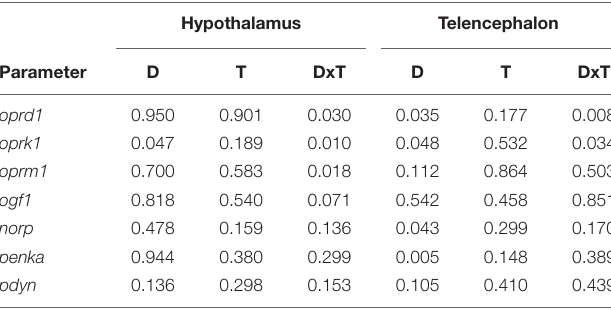
Figure 4 . The mRNA abundance of oprk1 was higher in fish fed HFD than in fish fed control diet after 3 h in hypothalamus (F1 = 3.256, p = 0.047) ( Figure 4B ) and telencephalon (F1 = 4.157, p = 0.048) ( Figure 4G ). The values of oprd1 in telencephalon ( Figure 4F ) of fish fed HFD were higher after 3 h than in fish fed control diet (F1 = 5.203, p = 0.035). No changes occurred in mRNA abundance of oprm1 ( Figures 4C,H ) and ogf1 ( Figures 4D,I ). The values of norp in telencephalon ( Figure 4J ) after 6 h were lower in fish fed HFD than those fed control diet (F1 = 4.727, p =